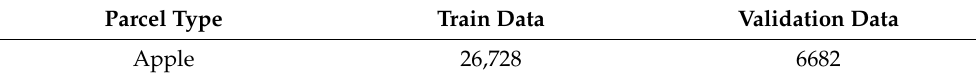
Table 2. Table of sample